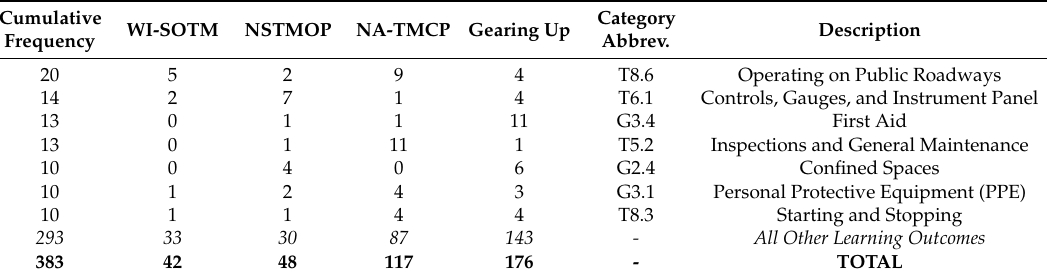
Table 8. Tertiary Learning Outcomes with Highest Frequency, by